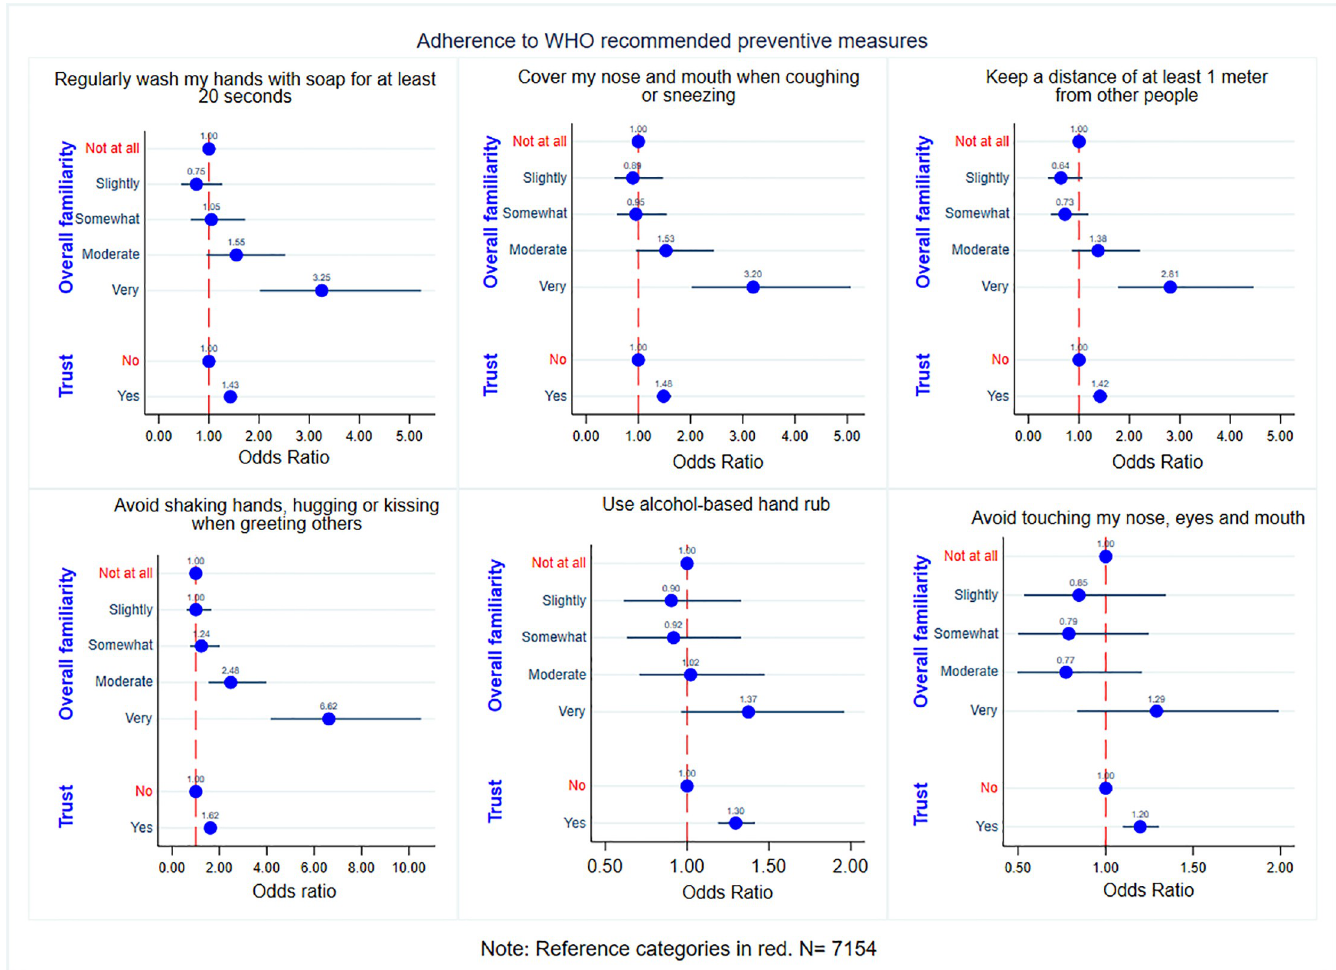
Fig 3. Odds ratio for adherence to WHO recommended preventive measures by overall familiarity and trust in information from the WHO.